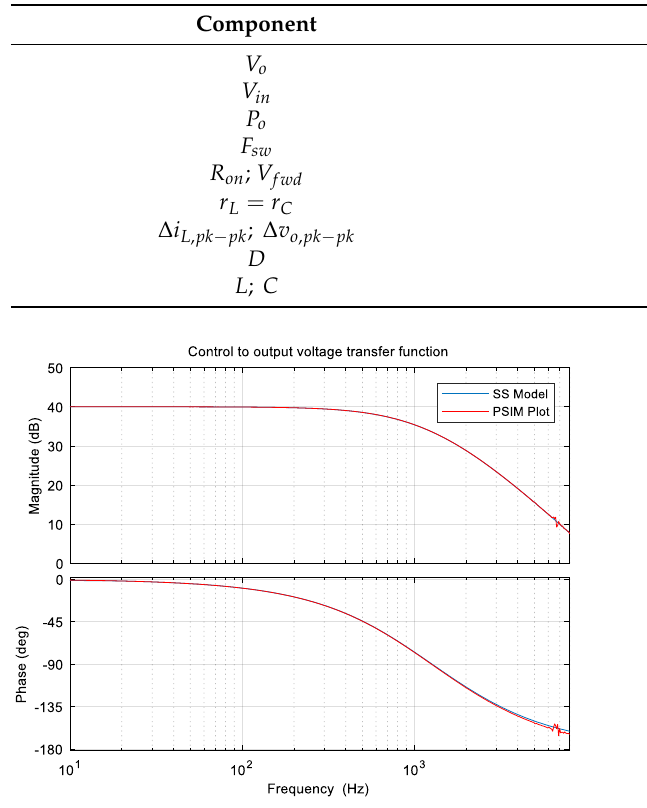
Table 8. Voltage-fed full-bridge converter parameters.